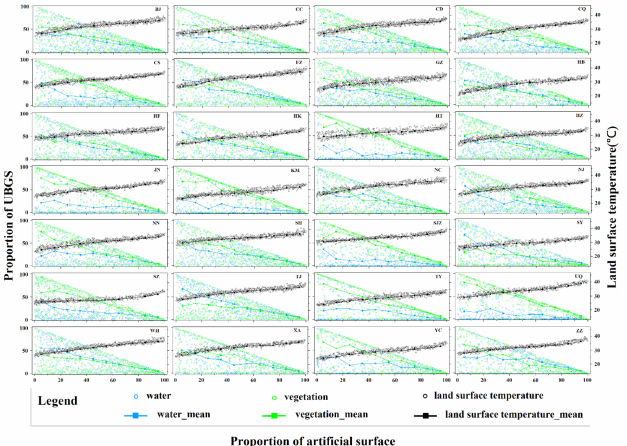
Figure 5. The proportion of UBGS (water and vegetation) and mean LST in each grid cell sample along the proportion gradients of AS throughout the 28 major urban areas. The circles show the grid cell sample value for each interval, and the squares reflect the mean value of the samples in each group. BJ (Beijing), CC (Changchun), CD (Chengdu), CQ (Chongqing), CS (Changsha), FZ (Fuzhou), GZ (Guangzhou), HB (Harbin), HF (Hefei), HK (Haikou), HH (Hohhot), HZ (Hangzhou), JN (Jinan), KM (Kunming), NC (Nanchang), NJ (Nanjing), NN (Nanning), SH (Shanghai), SJZ (Shijiazhuang), SY (Shenyang), SZ (Shenzhen), TJ (Tianjin), TY (Taiyuan), UQ (Urumqi), WH (Wuhan), XA (Xi’an), YC (Yinchuan), ZZ